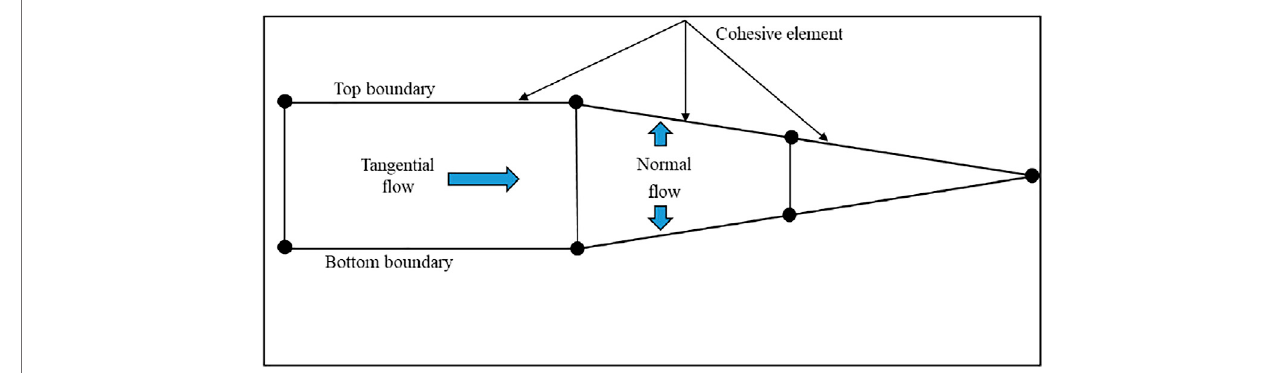
FIGURE 1 | Fluid fl ow in the